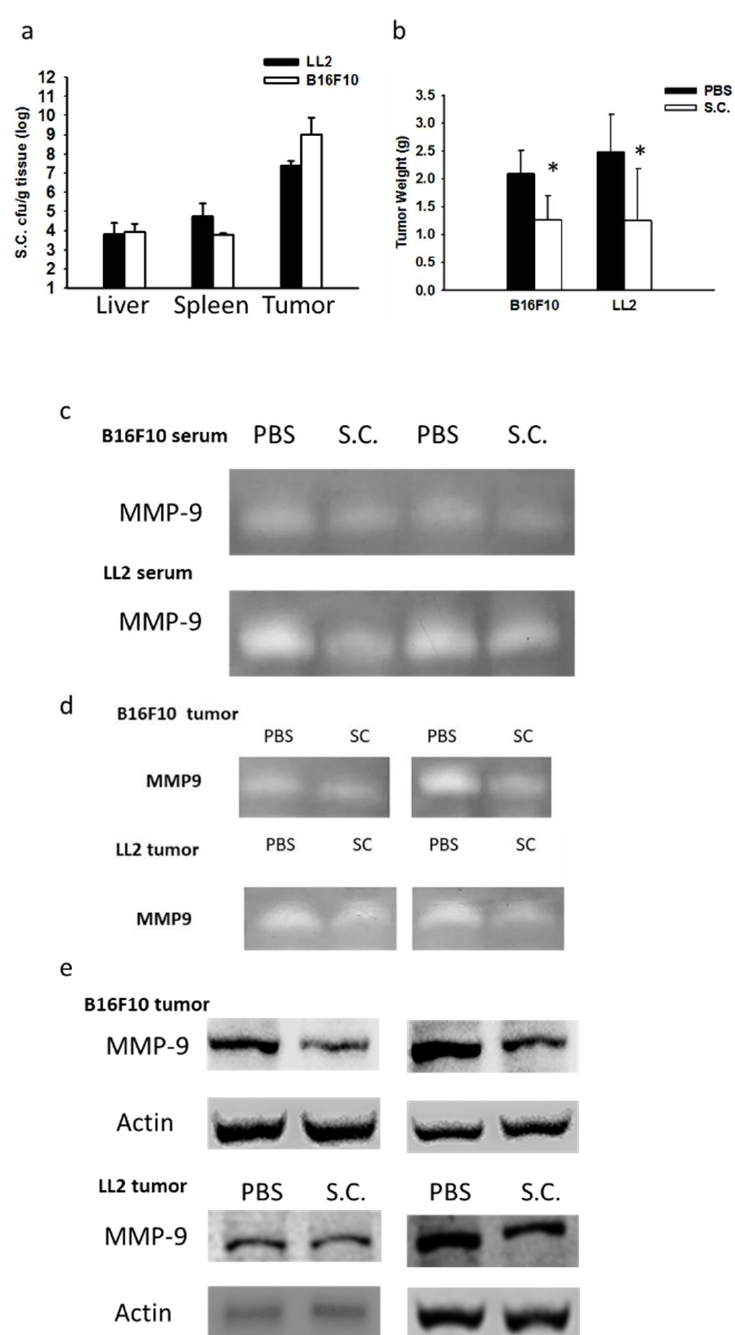
Figure 4. Salmonella (S.C.) reduced the function and expression of MMP-9 in vivo. The C57BL/6 mice had been subcutaneously inoculated with B16F10 and LL2 cells at day 0, and the tumor bearing mice were intraperitoneal injected with Salmonella (10 6 cfu) at day 7. At day 10, the mice were sacrificed. The serum, tumors, livers, and spleen were collected. ( a ) The amounts of accumulated Salmonella in organs was determined; ( b ) The antitumor activity of Salmonella was determined by tumor weight. ( n = 4, data are mean ± SD. * p < 0.05); The enzyme activity of MMP-9 in serum ( c ) and tumors ( d ) was determined by gelatin zymography; ( e ) The protein expression of MMP-9 in tumors derived from Salmonella -treated mice or control mice was determined by Western blotting.